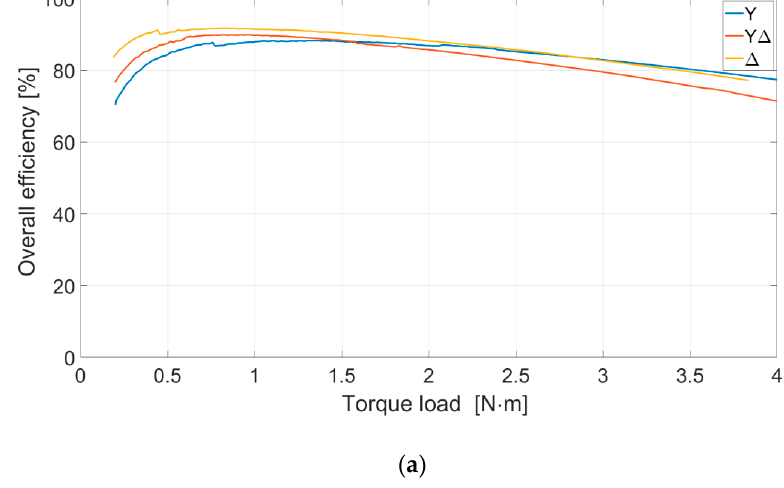
Figure 24. Speed vs. load torque for Y, Y Δ and Δ configurations: ( a ) healthy mode; ( b ) OC fault state.